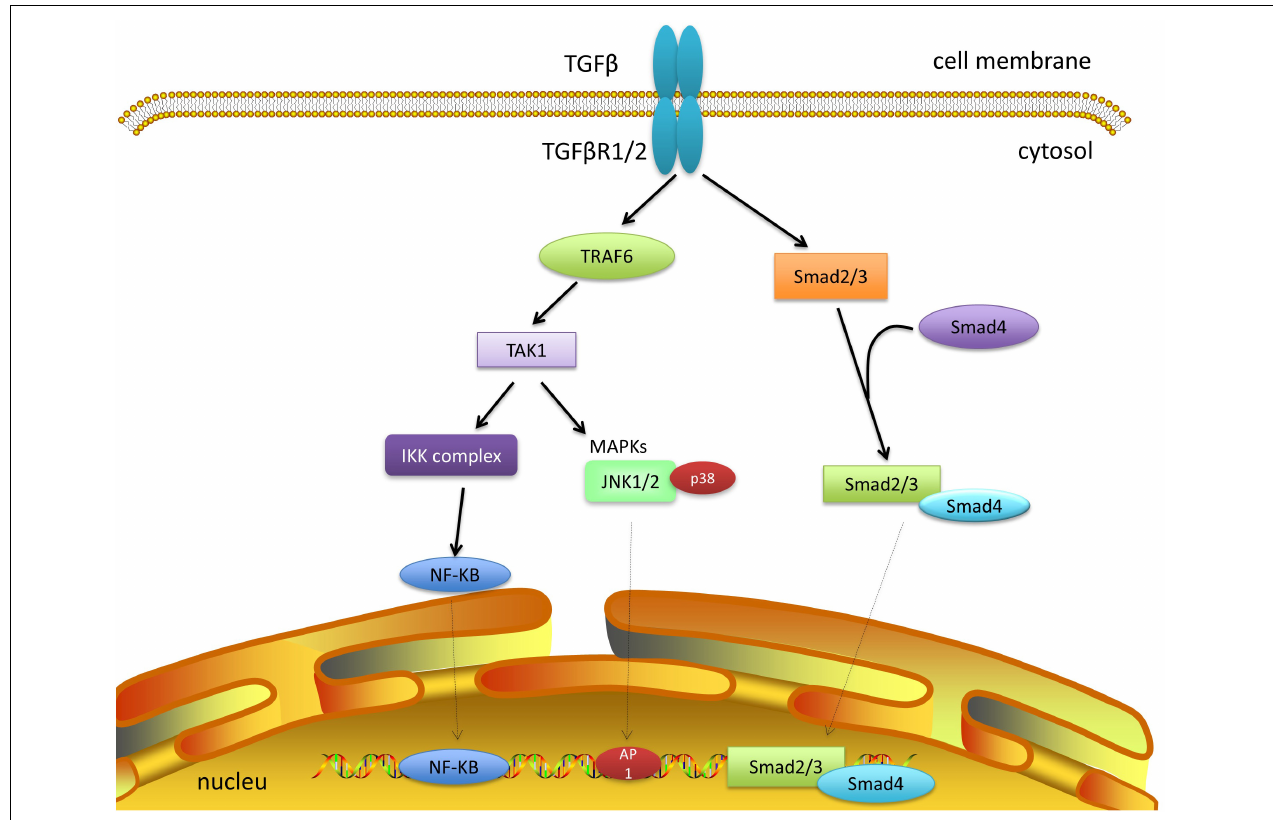
FIGURE 2 | TAK1 and TGF- β signaling. TGF- β and its receptor form a complex and recruit TRAF6. The polyubiquitylation of TRAF6 can activate TAK1, which promotes subsequent cascades, including JNK, P38, and NF- κ B. Smad-dependent signaling has not been discussed further